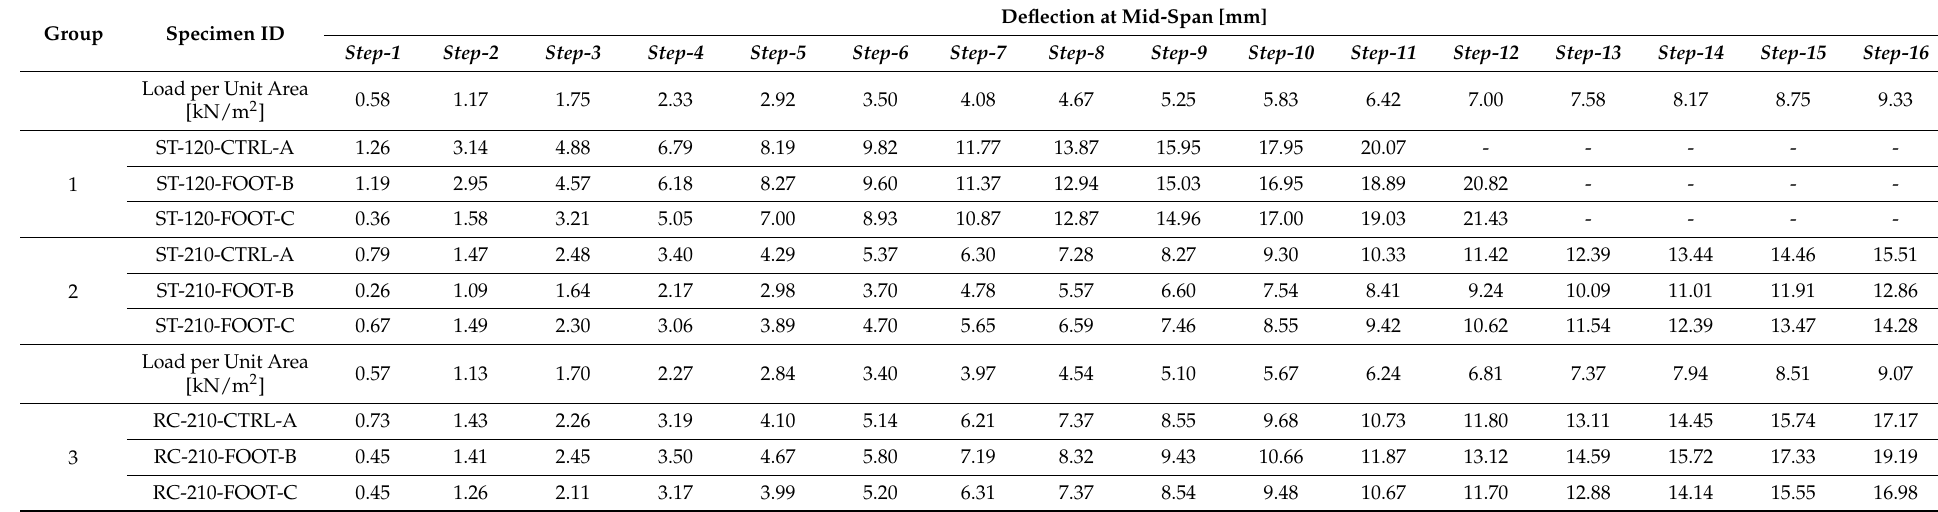
Table 5. Summary of test